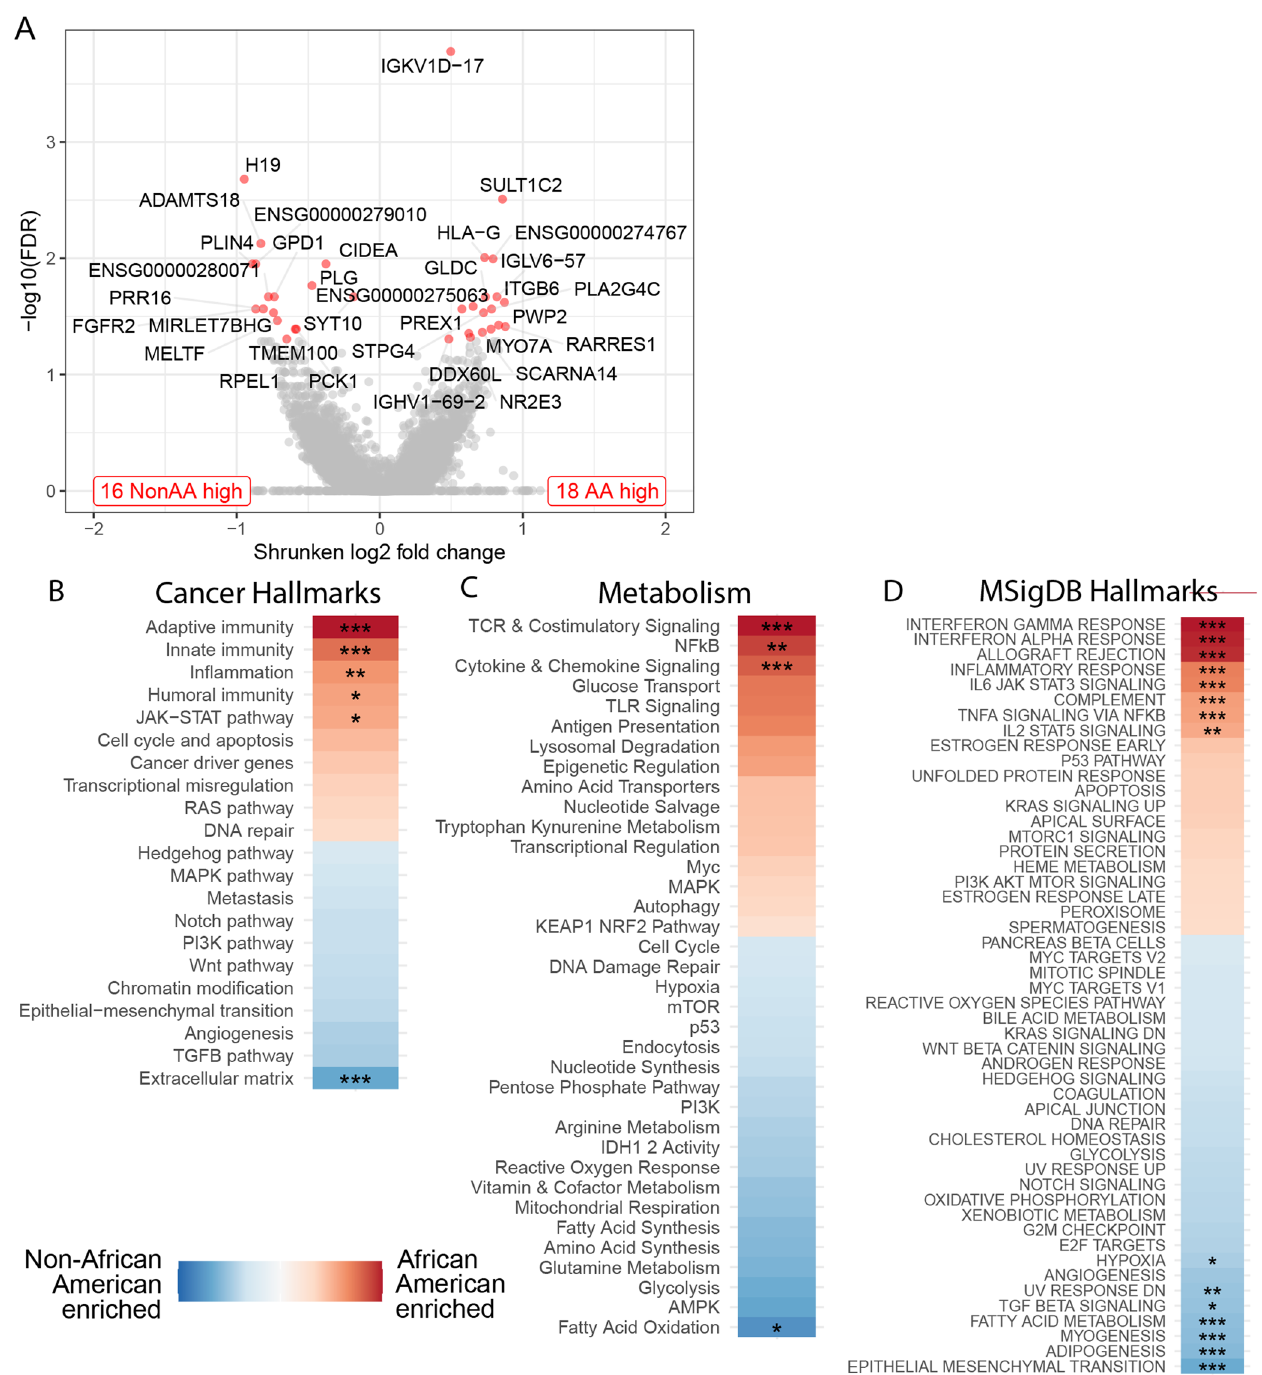
Fig. 2 Differentially expressed genes and pathways in Non-African American (NonAA) and African American (AA) TNBC patients. A Volcano plot of differentially expressed genes (FDR < 0.05 and |log2 fold change | > 1 | )) are labeled and marked red. The number of up- regulated genes are shown in bottom corners. B – D Gene set enrichment analysis of Nanostring hallmarks of cancer gene set ( B ), Nanostring metabolic pathways ( C ), and hallmark pathways from MSigDB database ( D ). Color coding shows the directionality of enrichment. Stars indicate signi fi cant results (*adjusted p < 0.05, **adjusted p < 0.01, ***adjusted p < 0.001; Wald Test, Permutation Test). cyan) in AA patients ( p < 0.001; Permutation Test) (Fig. 3B). The lower or higher expression) and mutation status varied from gene association between module membership, a measure of high to gene and across cohorts (Supplementary Data File Table 5). gene connectivity within a module, and test statistic used for Unsupervised clustering of 14,609 genes revealed 11 co- fi nding differentially expressed genes was negative in the expression modules indicated by different colors in Fig. 3A and turquoise ( p = 8.2e – 14; Permutation Test) and green ( p = 0.056; Supplementary Fig. 6. Three modules (turquoise, cyan, and green) Permutation Test) modules and positive in the brown ( p < 2.2e – 16; were signi fi cantly more highly expressed in NonAA patients Permutation Test) and light cyan ( p < 2.2e – 16; Permutation Test) ( p < 0.001; Permutation Test) and two modules (brown and light npj Breast Cancer (2022) 88 Published in partnership with the Breast Cancer Research